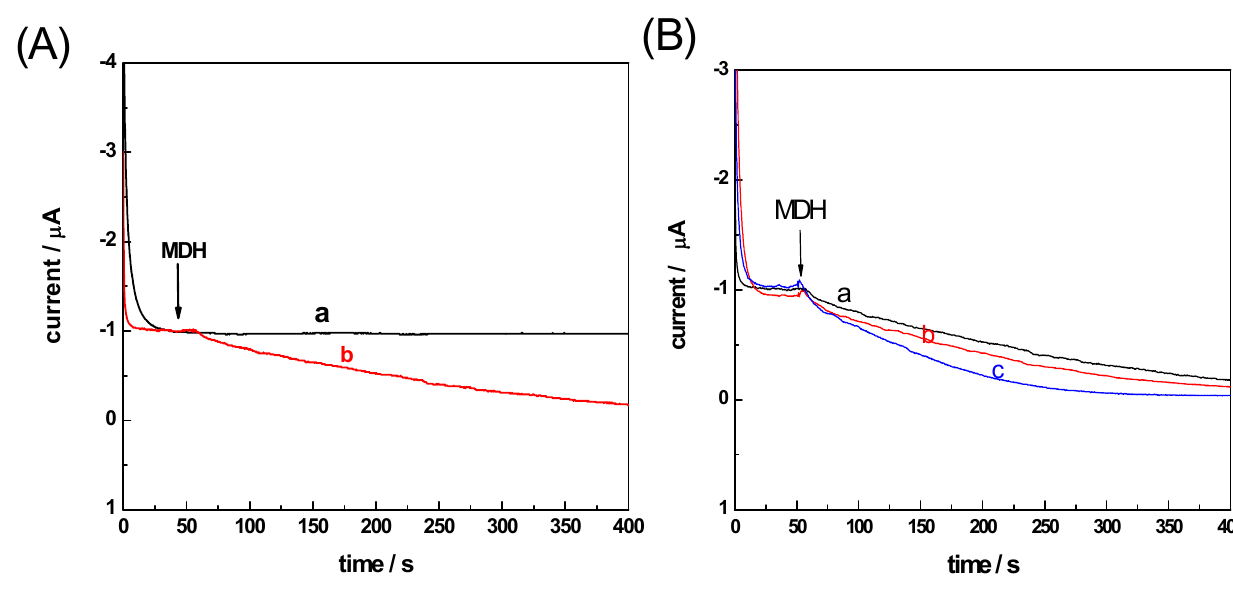
Figure 2. Amperometric response of the MWNT-modified electrode to the oxidation of NADH in a well-stirred assay mixture: 1 mM oxaloacetate + 1 mM NADH + 100 mM Tris-HCl buffer (pH 7.5) + MDH ( A ) ( a ) 0 μ L MDH ( b ) 10 μ L MDH. ( B ) ( a ) no Al (III) and Al ( b ) 30 μ M Al (III) ( c ) 30 μ M Al . 13 13